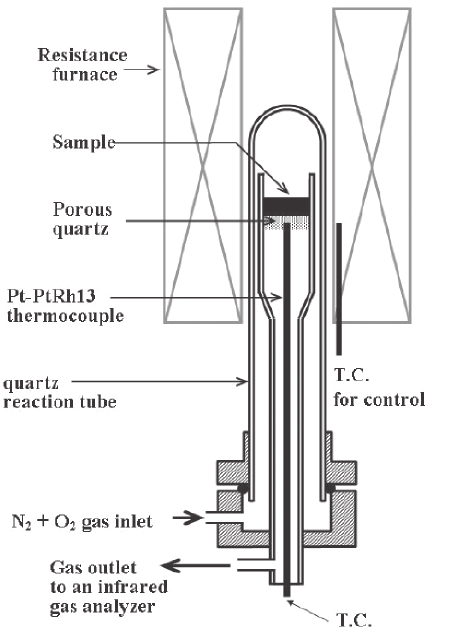
Fig. 3: Variations of temperature and gases (CO and CO 2 ) in outlet gas during